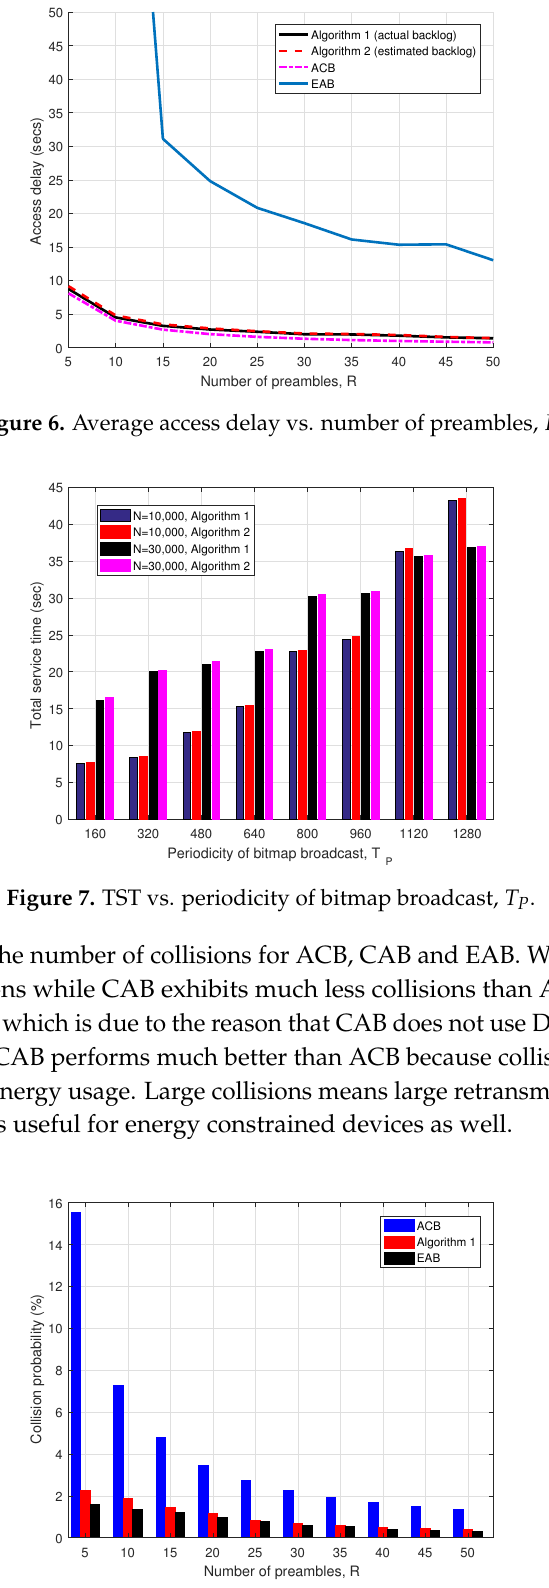
Figure 8. Number of collisions vs. number of preambles, R